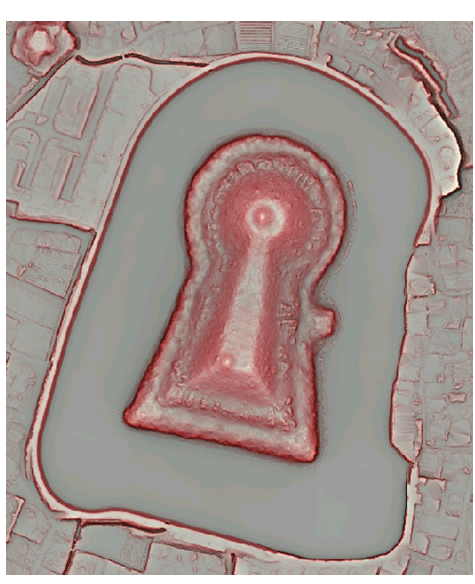
Fig9. Gobyouyama Mounded Tomb(RRIM of Lidar data)